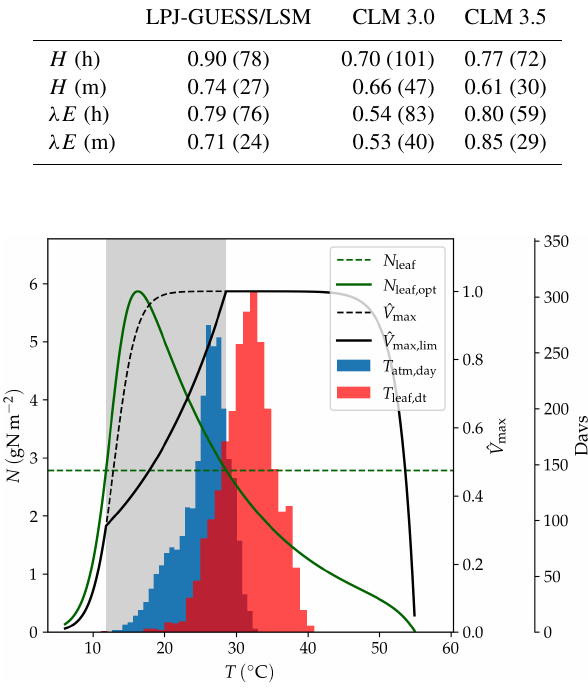
Figure 16. Effect of temperature ( T ) on modelled V max ; N leaf,opt : leaf nitrogen content necessary to attain the maximum carboxyla- tion rate; N leaf : representative leaf nitrogen concentration; ˆ V max : normalized maximum carboxylation rate without nitrogen limita- tion; ˆ V max,lim : normalized maximum carboxylation rate with nitro- gen limitation. The histograms show the frequency of temperatures in the AU-DaP simulation; T atm,day : daily average of air tempera- ture; T leaf,dt : daytime average of leaf temperature. The shaded area indicates the temperature range where V max is